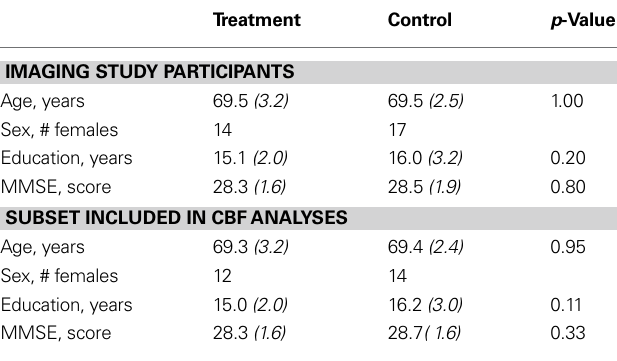
Table 1 | Demographic data for study